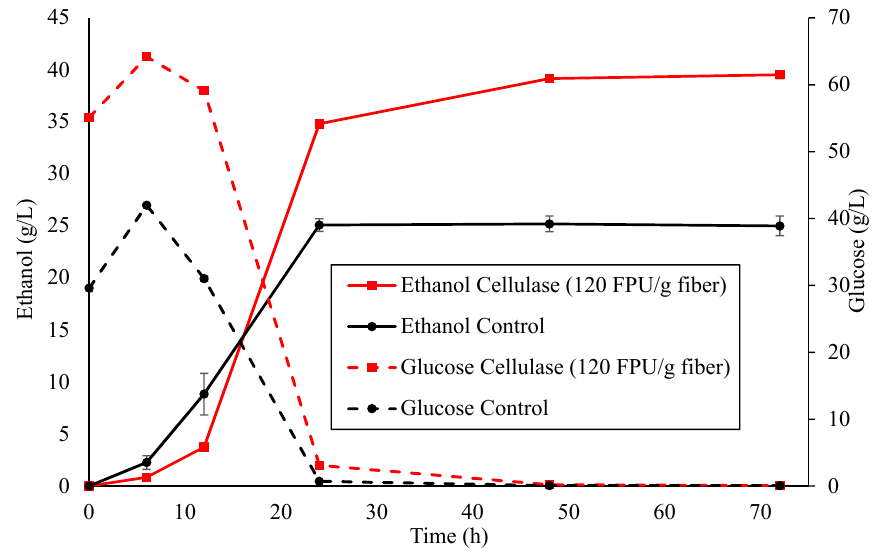
Figure 3. Ethanol and glucose profiles for untreated fiber converted through SSF performed with excess fiber cellulase addition.